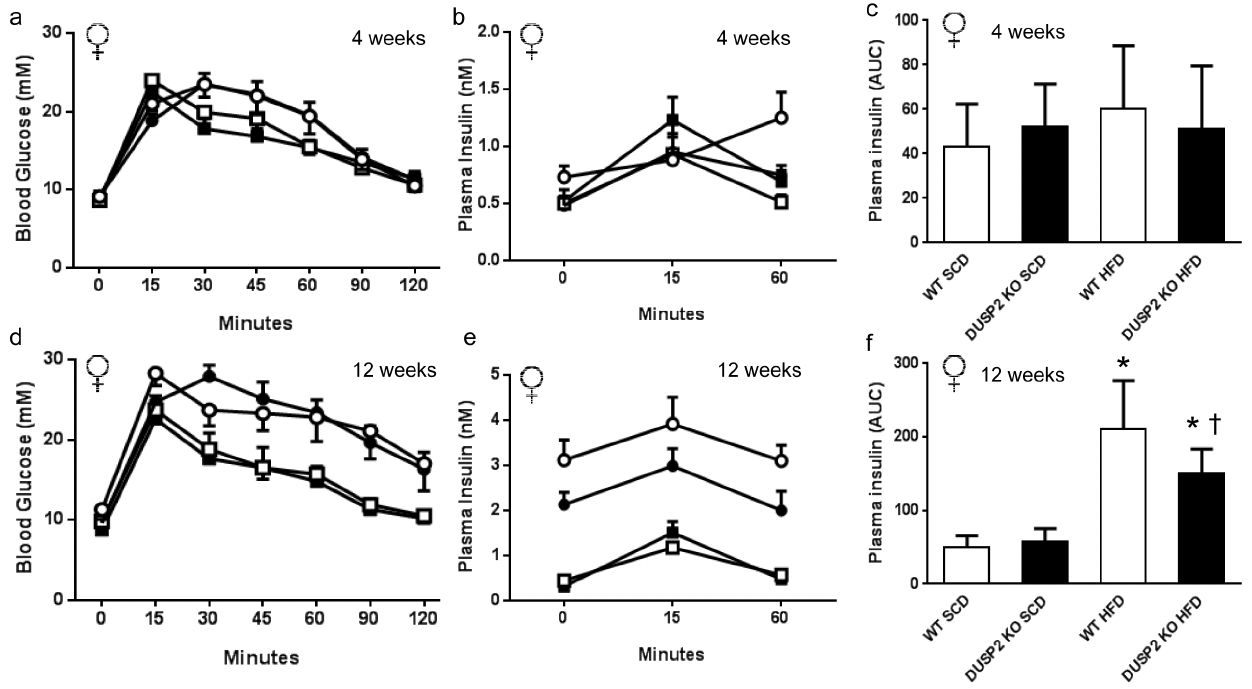
Figure 4. Glucose tolerance and insulin sensitivity in wt and dusp2 2 / 2 female mice. ( a and d ) oral glucose tolerance; ( b and e ) plasma insulin during the OGTT; and ( c and f ) plasma insulin area under the curve (AUC). *p , 0.05; Interaction Effect wt SCD vs. wt HFD and dusp2 2 / 2 SCD vs. dusp2 2 / 2 HFD. { p , 0.05 Interaction Effect wt HFD vs. dusp2 2 / 2 HFD. Data are mean 6 SD. White squares are wt mice fed SCD; Black squares are dusp2 2 / 2 mice fed SCD; White circles are wt mice fed HFD; Black circles are dusp2 2 / 2 mice fed HFD. Ns are 9, 8, 7 and 7 at 4 weeks and 9, 7, 6 and 7 at 12 weeks for wt SCD, dusp2 2 / 2 SCD, wt HFD and dusp2 2 / 2 HFD, respectively.